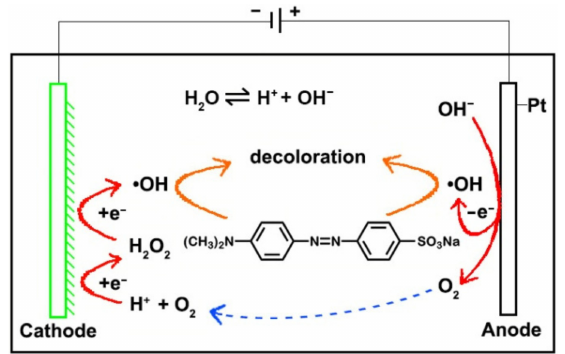
Figure 5. The mechanism diagram of MO decolorization